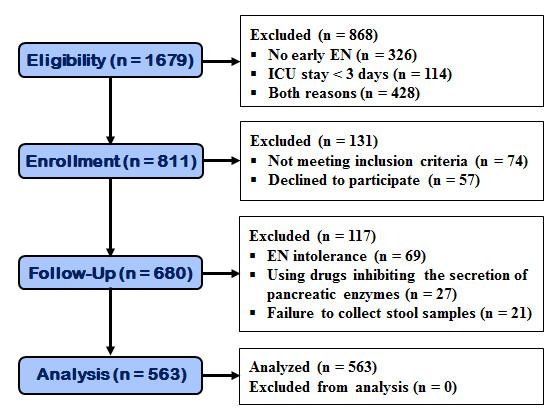
The CONSORT flow diagram for the study participants. EN, enteral nutrition.